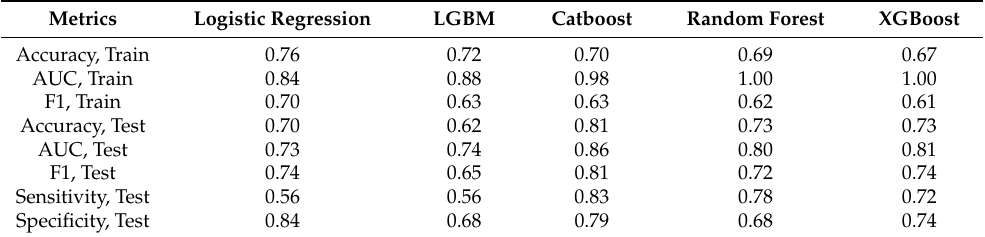
Table 5. ROC analysis results for the «CST2+ OCLN+ pT» model based on the Logistic Regression, LGBM, Catboost, Random Forest, and XGBoost